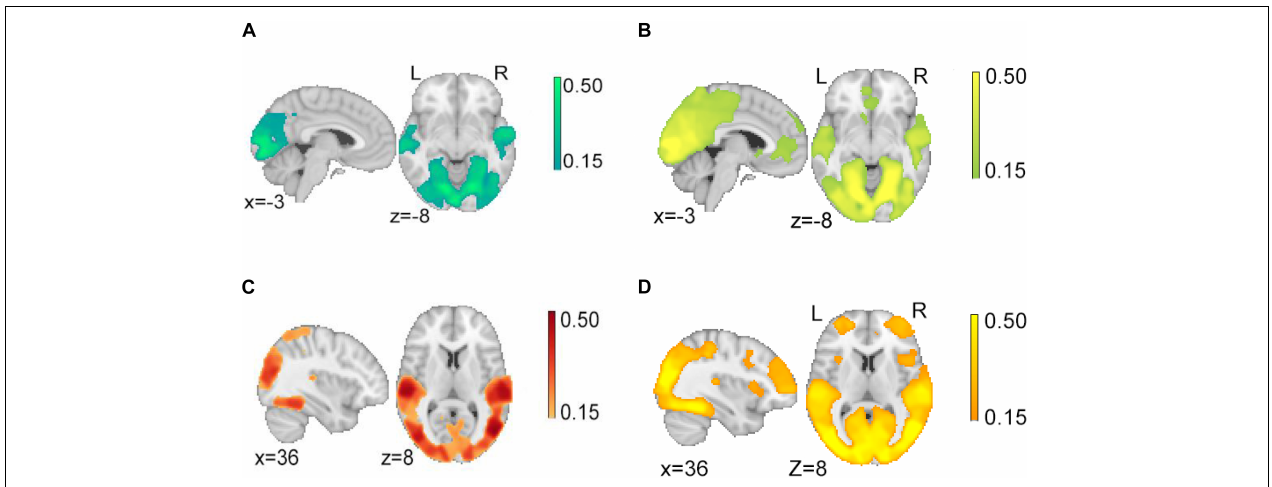
FIGURE 3 | Intersubject correlation (ISC) in character and action segments of justified and unjustified movie violence. We observed significant ISCs in temporal and occipital cortex associated with audio and visual processing for both (A) character and (B) action segments of justified movie violence. In contrast, we observed significant ISC in vmPFC and ACC of (B) action segments only. Similarly, we observed significant ISCs in temporal and occipital cortices related to auditory and visual processing for both (C) character and (D) action segments of unjustified movie violence. In contrast, we observed significant ISC in lOFC, MFG, and insula regions of (D) action segment only. The color bar provides ISC values, with a significance threshold set at r < 0.15, after applying a non-parametric family wise error, FWE, correction of q < 0.001.